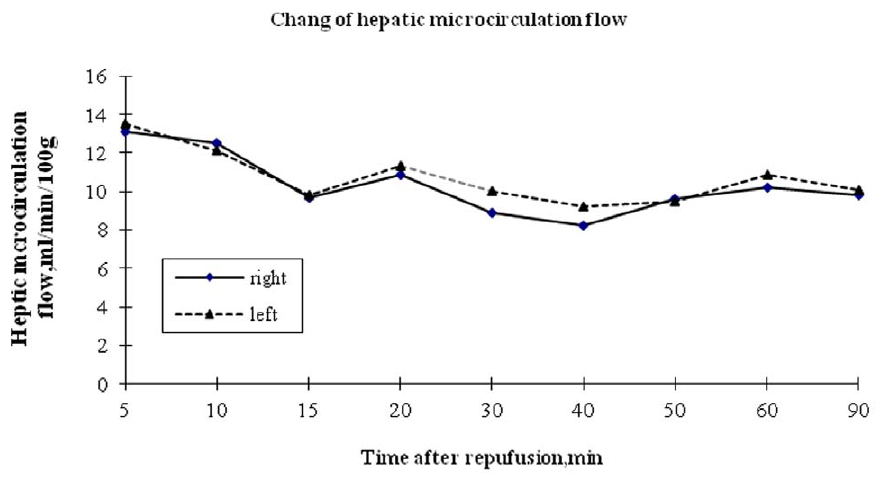
Figure 1. Change of hepatic microcirculation flow. Laser Doppler probe showed that no difference in microcirculation flow between orthotopically implanted graft and heterotopically positioned graft (p .